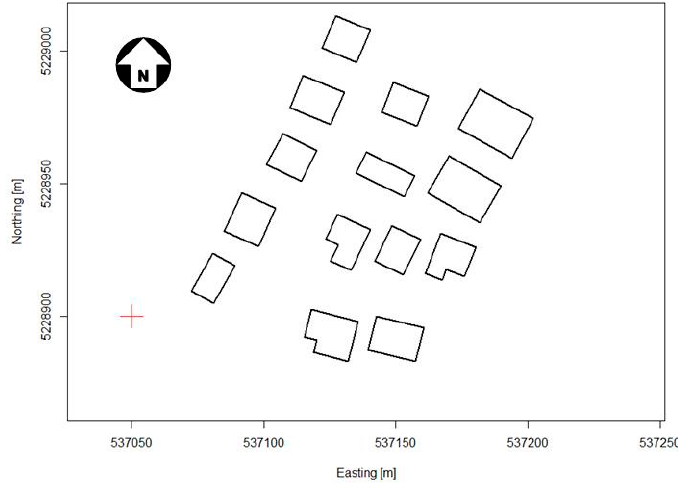
Figure 15. Enhanced vector map of class “building” (Level 2).